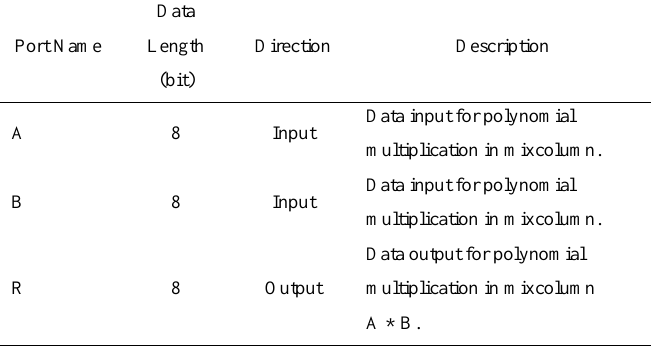
Fig. 12 Processing element design Table 8. Processing element pinout description